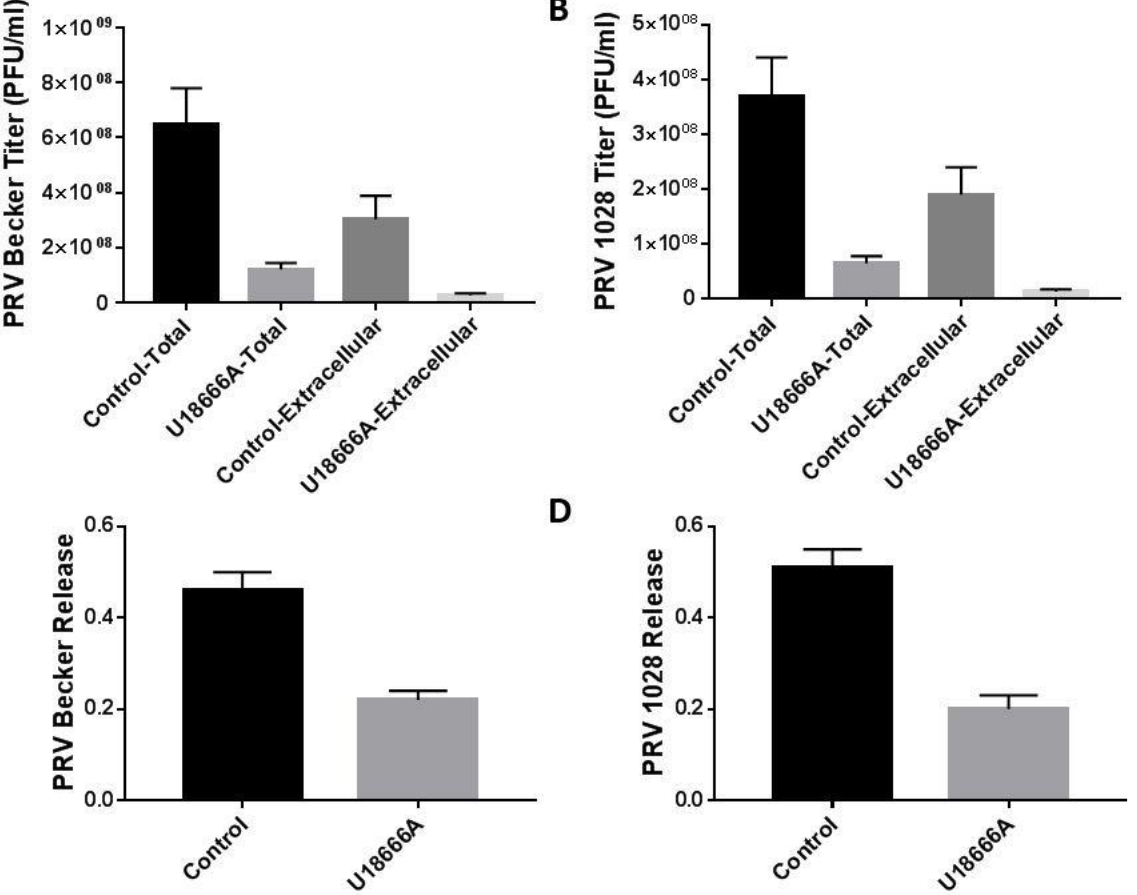
Figure 8. U18666A treatment suppresses the release of infectious PRV particles. PK-15 cells were infected with PRV at an MOI of 5 in the presence of U18666A (5 μg /mL) or DMSO (0.1%, v/v ) as a control. Samples (cells and supernatants) were harvested at 24 h post-infection. ( A , B ) The levels of infectious virus particles in the cell and supernatant (extracellular) fractions were determined by plaque assay. The total virus titer was defined as the combined virus titer from the cell and the extracellular fractions. ( C , D ) Virus release was defined as the ratio of the virus titer in the extracellular fraction and the virus titer in the total fraction: Release = [virus titer in extracellular fraction] / [virus titer in total fraction]. Data are mean ± SD ( n = 3).